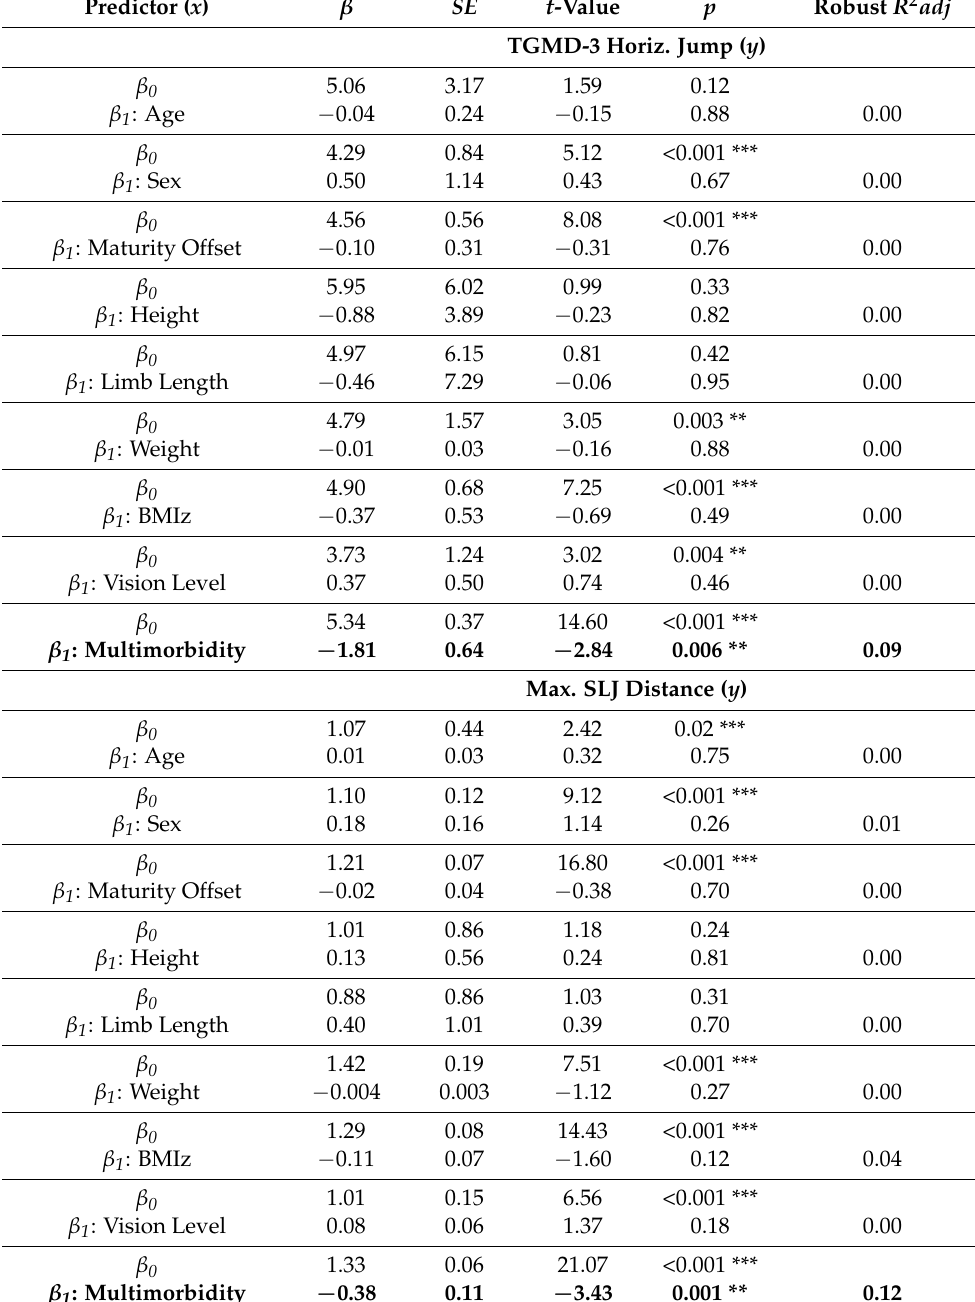
Table 4. Individual robust bivariate regression results for the potential variables of